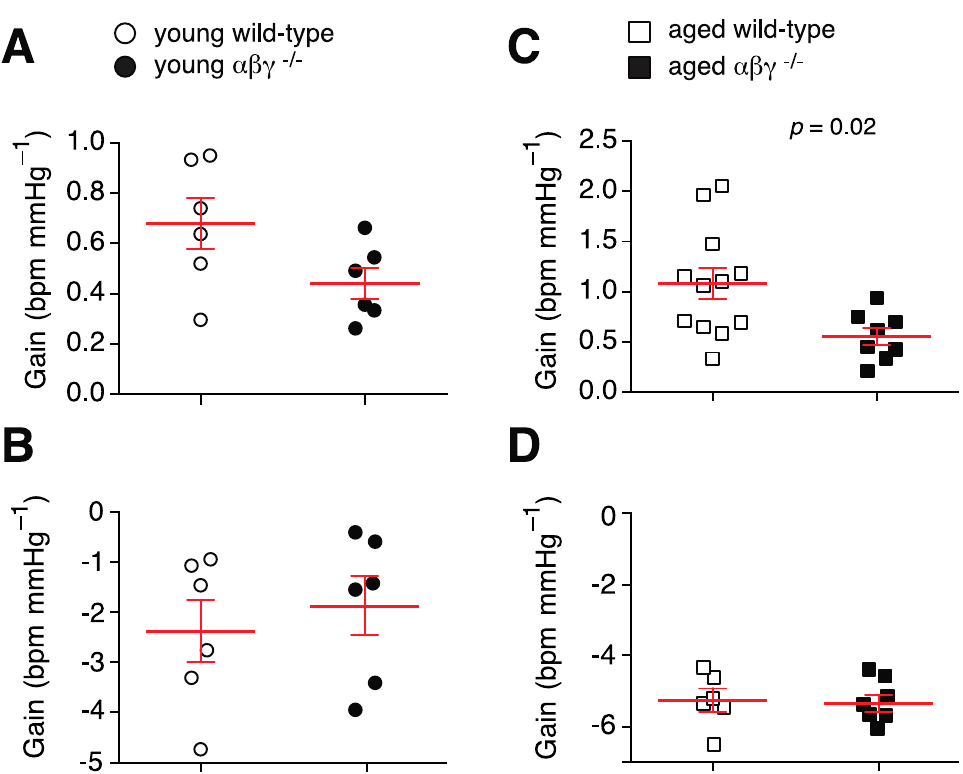
Figure 4. Comparisons of baroreflex gain in wild-type and αβγ − / − mice. ( A ) Depressor reflex in aged mice. ( B ) Pressor reflex in aged mice. ( C ) Depressor reflex in young mice. ( D ) Pressor reflex in young mice. Means ± S.E.M were compared with Mann–Whitney U rank test.